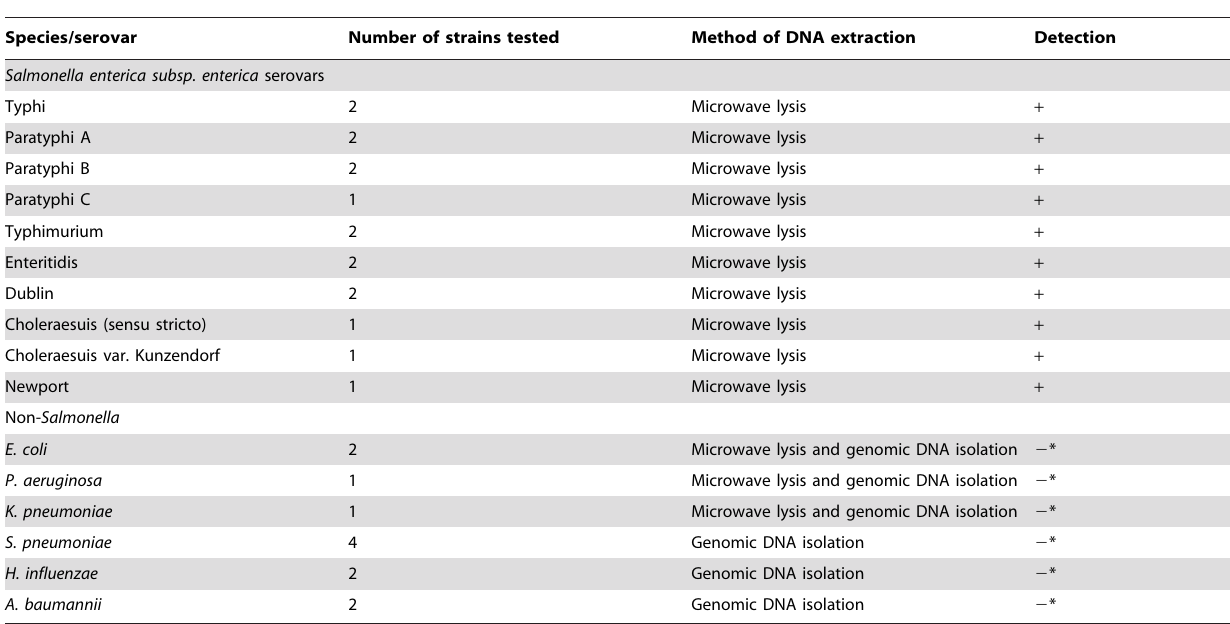
Table 1. Detection of Salmonella and non- Salmonella strains that are commonly found in blood.